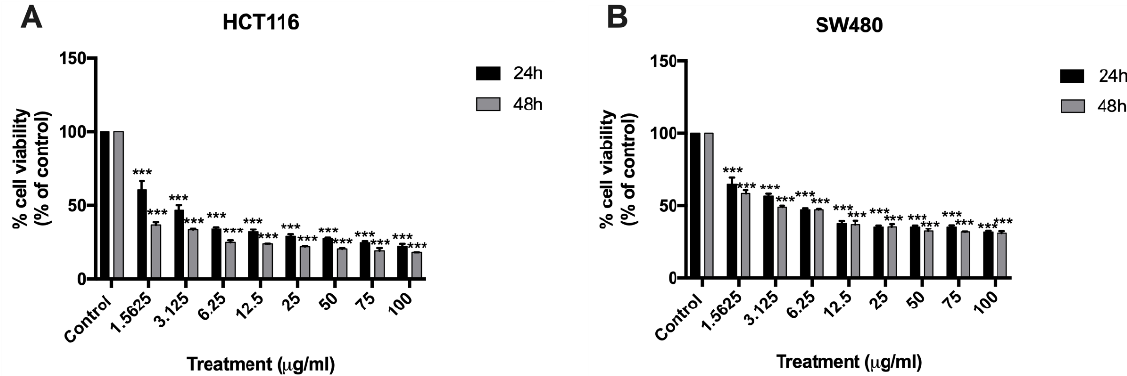
Figure 2. MTT assay showing the cytotoxic effect of BA at 24 and 48 h against HCT116 ( A ) and SW480 ( B ) colorectal cancer cells at BA concentrations ranging from 1.5625 to 100 ug/mL. Results are presented as mean ± standard error of the mean (SEM). Experiments were carried out in triplicate. One-way ANOVA and with Dunnett’s post hoc test were used to test statistical significance with *** indicating p < 0.001 vs. control group.